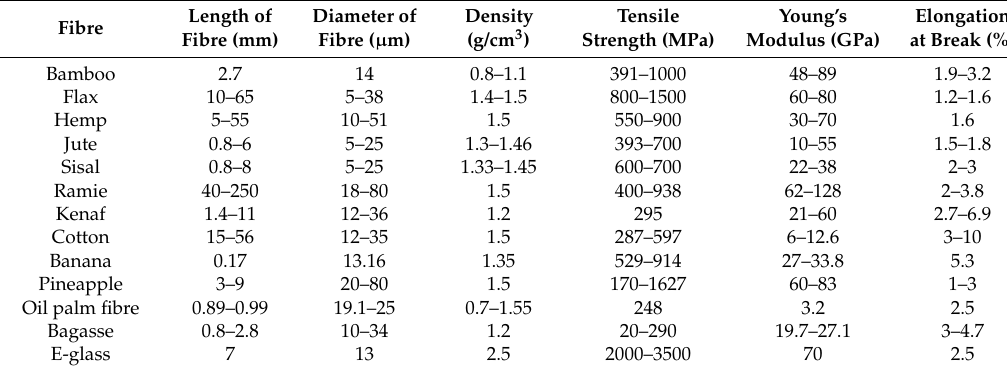
Table 3. Physical and mechanical properties of natural fibres and glass fibres [7,18,30,35,36]. Length of Diameter of Density Tensile Young’s Fibre Fibre (mm) Fibre ( µ m) (g/cm 3 ) Strength (MPa) Modulus